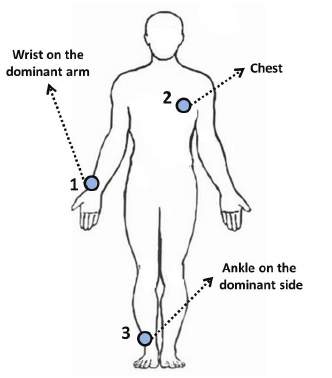
Figure 3. Location of the three wearable sensors used in the dataset (hand, chest and ankle), adapted from [21]. Table 2. Physical activities identified in this case study, adapted from